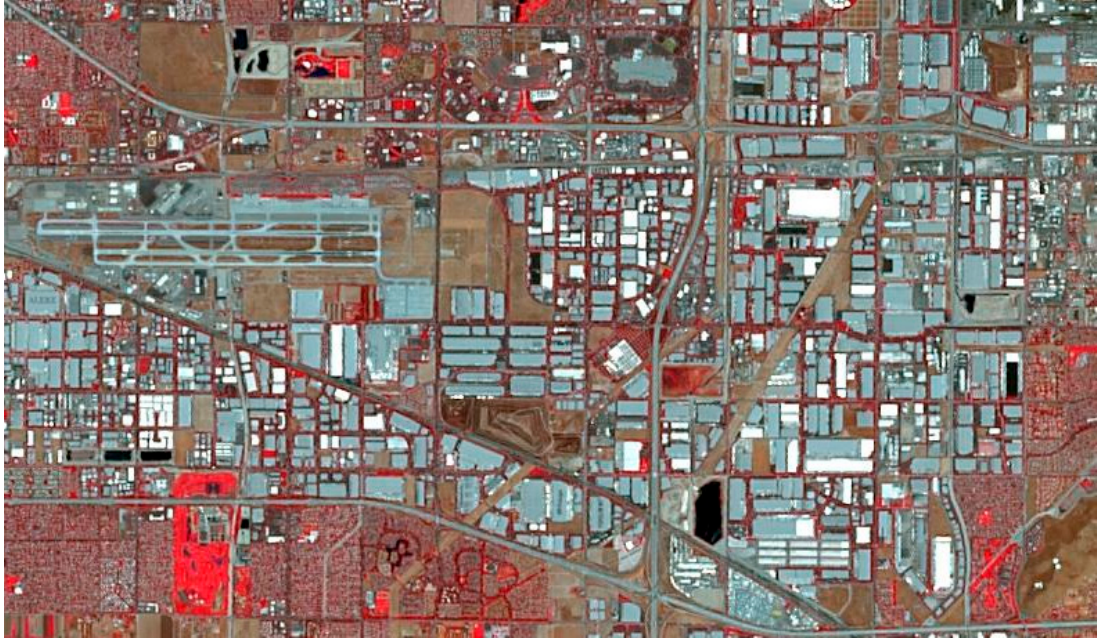
Figure 10. Landsat images are collected nadir. Sides of buildings cannot be seen.